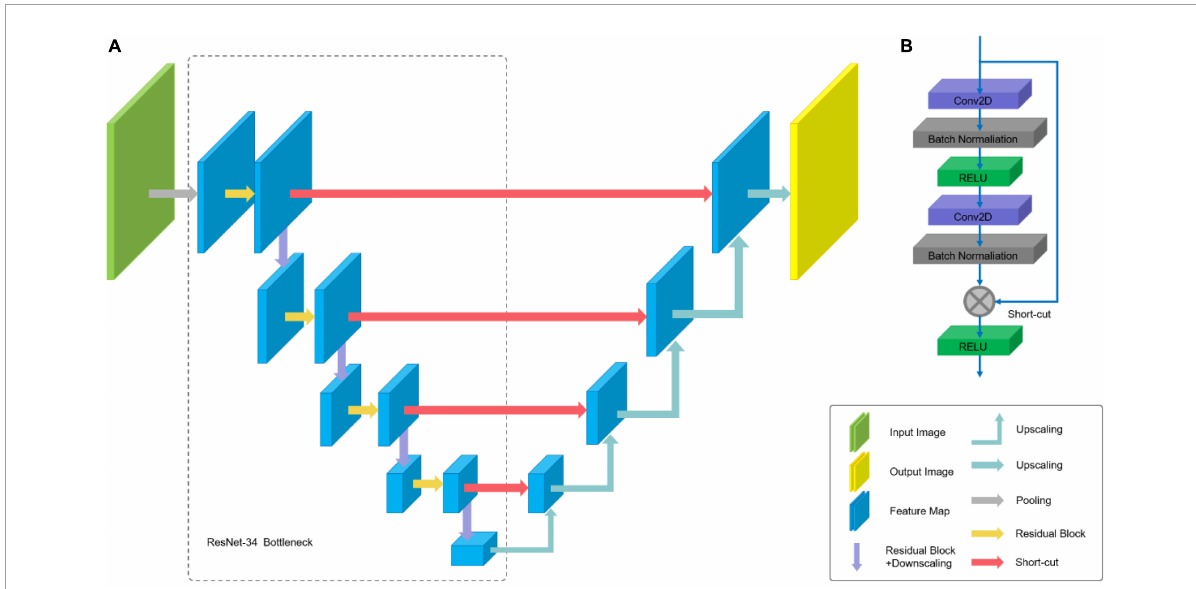
FIGURE6 Architecture of U-Net: (A) U-Net-like architecture build with pre-trained ResNet-34; (B) residual Block.